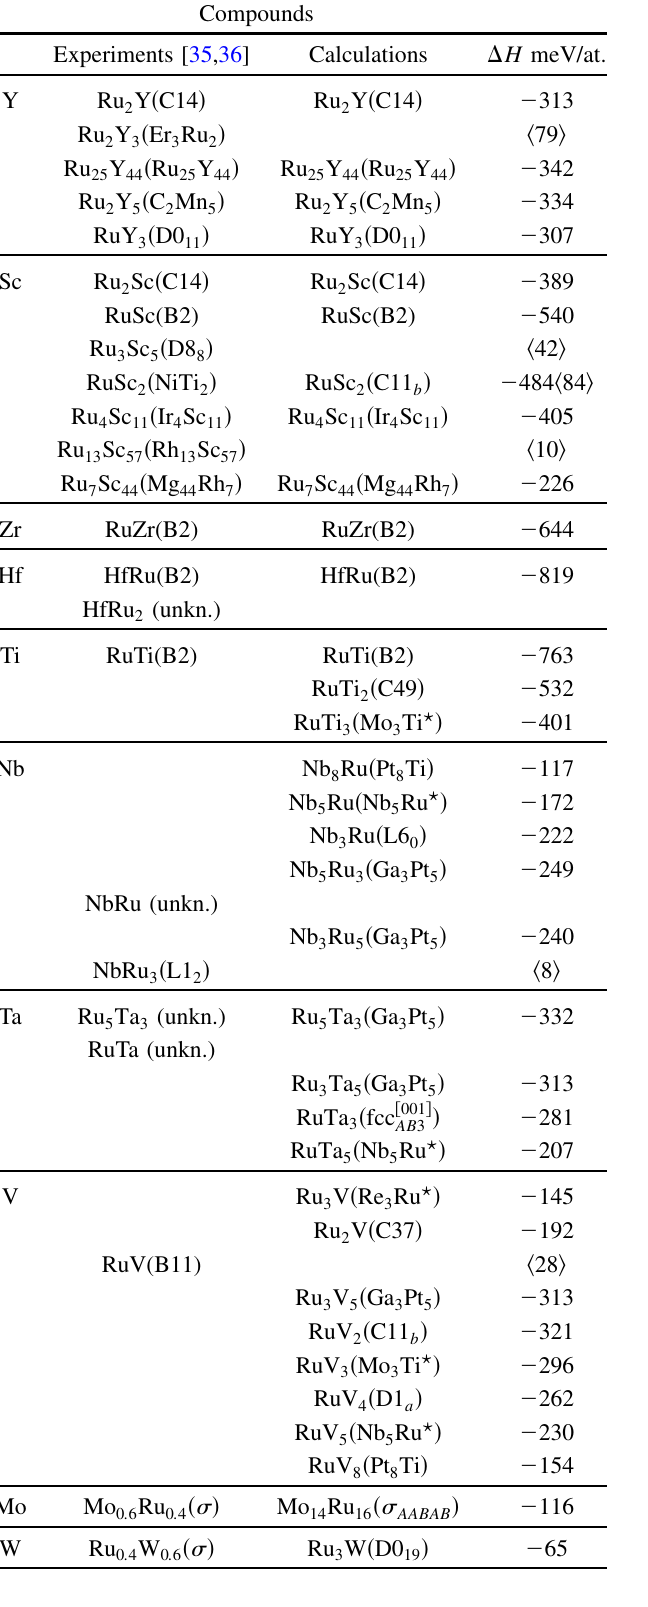
TABLE II. Compounds in Ruthenium binary alloys. The term (unkn.) denotes an unknown structure. All other symbols are as in Table